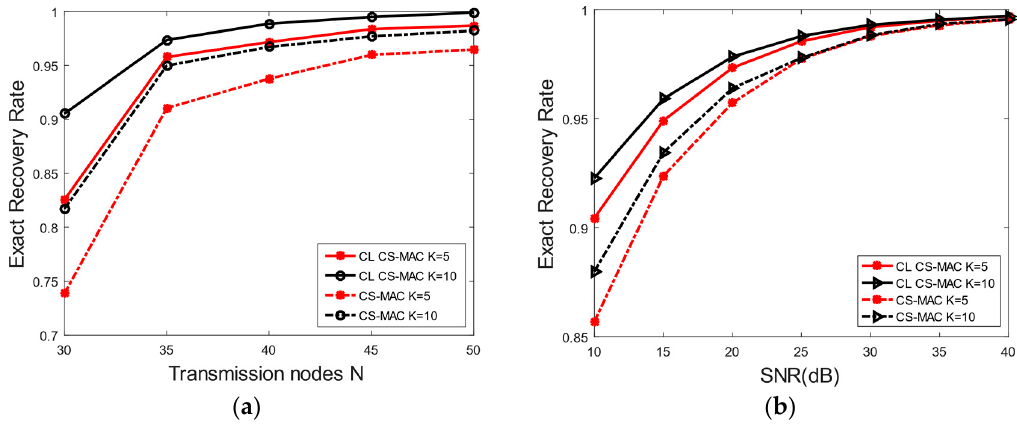
Figure 7. Software simulation of exact recovery rate. ( a ) Exact recovery rate of transmission nodes; ( b ) Exact recovery rate of different SNR.